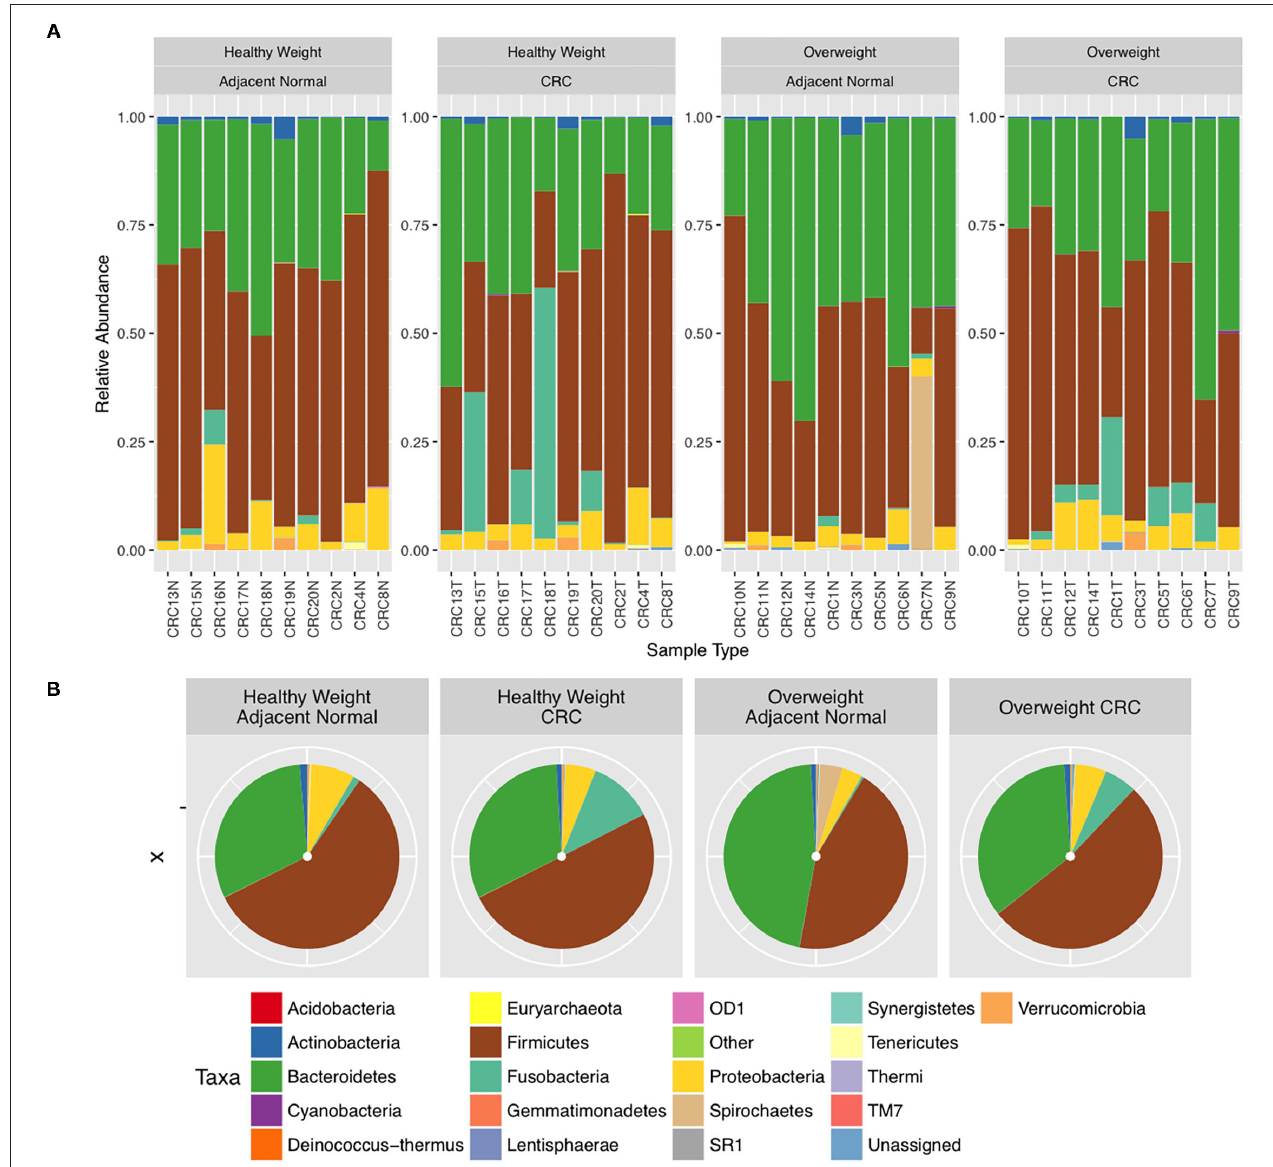
FIGURE 2 | Relative abundance at phylum level for colorectal cancer (CRC) tissue and paired adjacent normal mucosa samples. (A) Individual subject stacked bar charts. (B) Collective pie chart